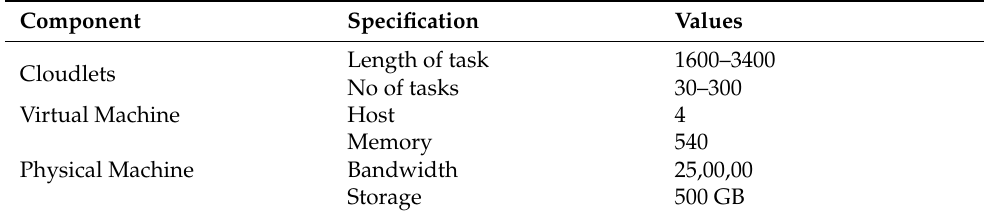
Table 3. Simulation Settings.